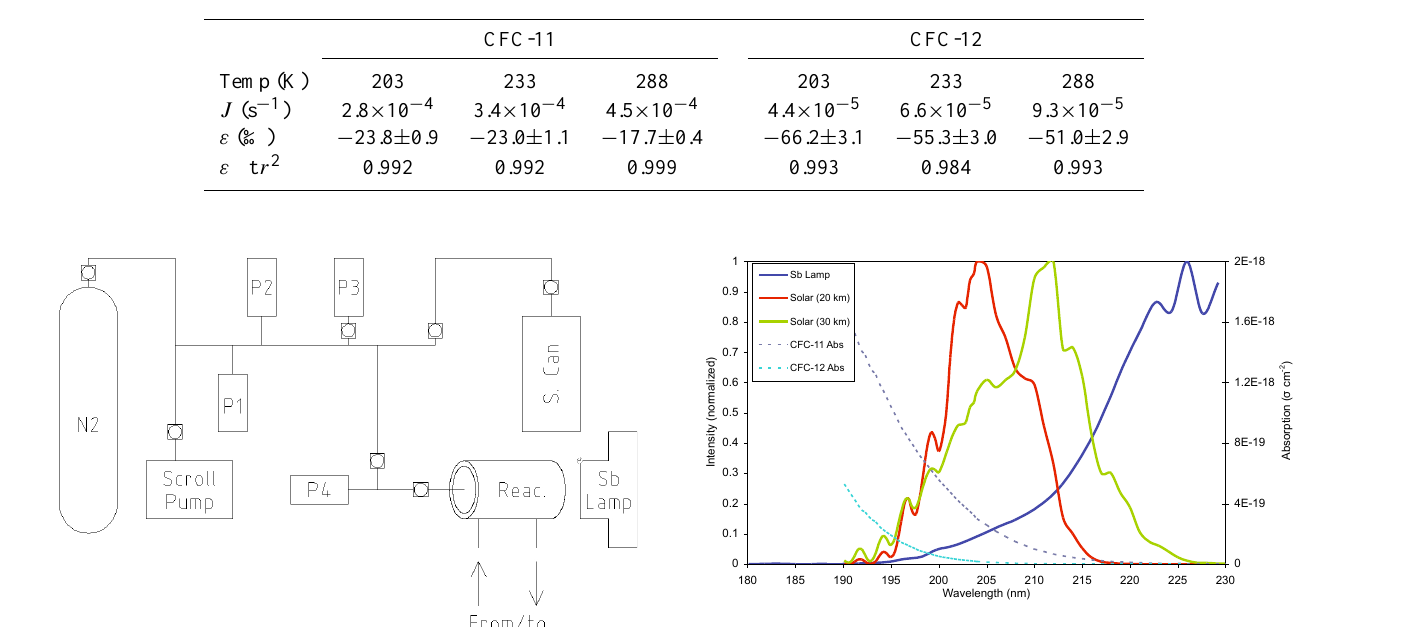
by using a 52.5 m × 0.25 mm Poraplot Q column, the effluent of which is split to (1) a HP 5970 quadrupole MS and (2) a